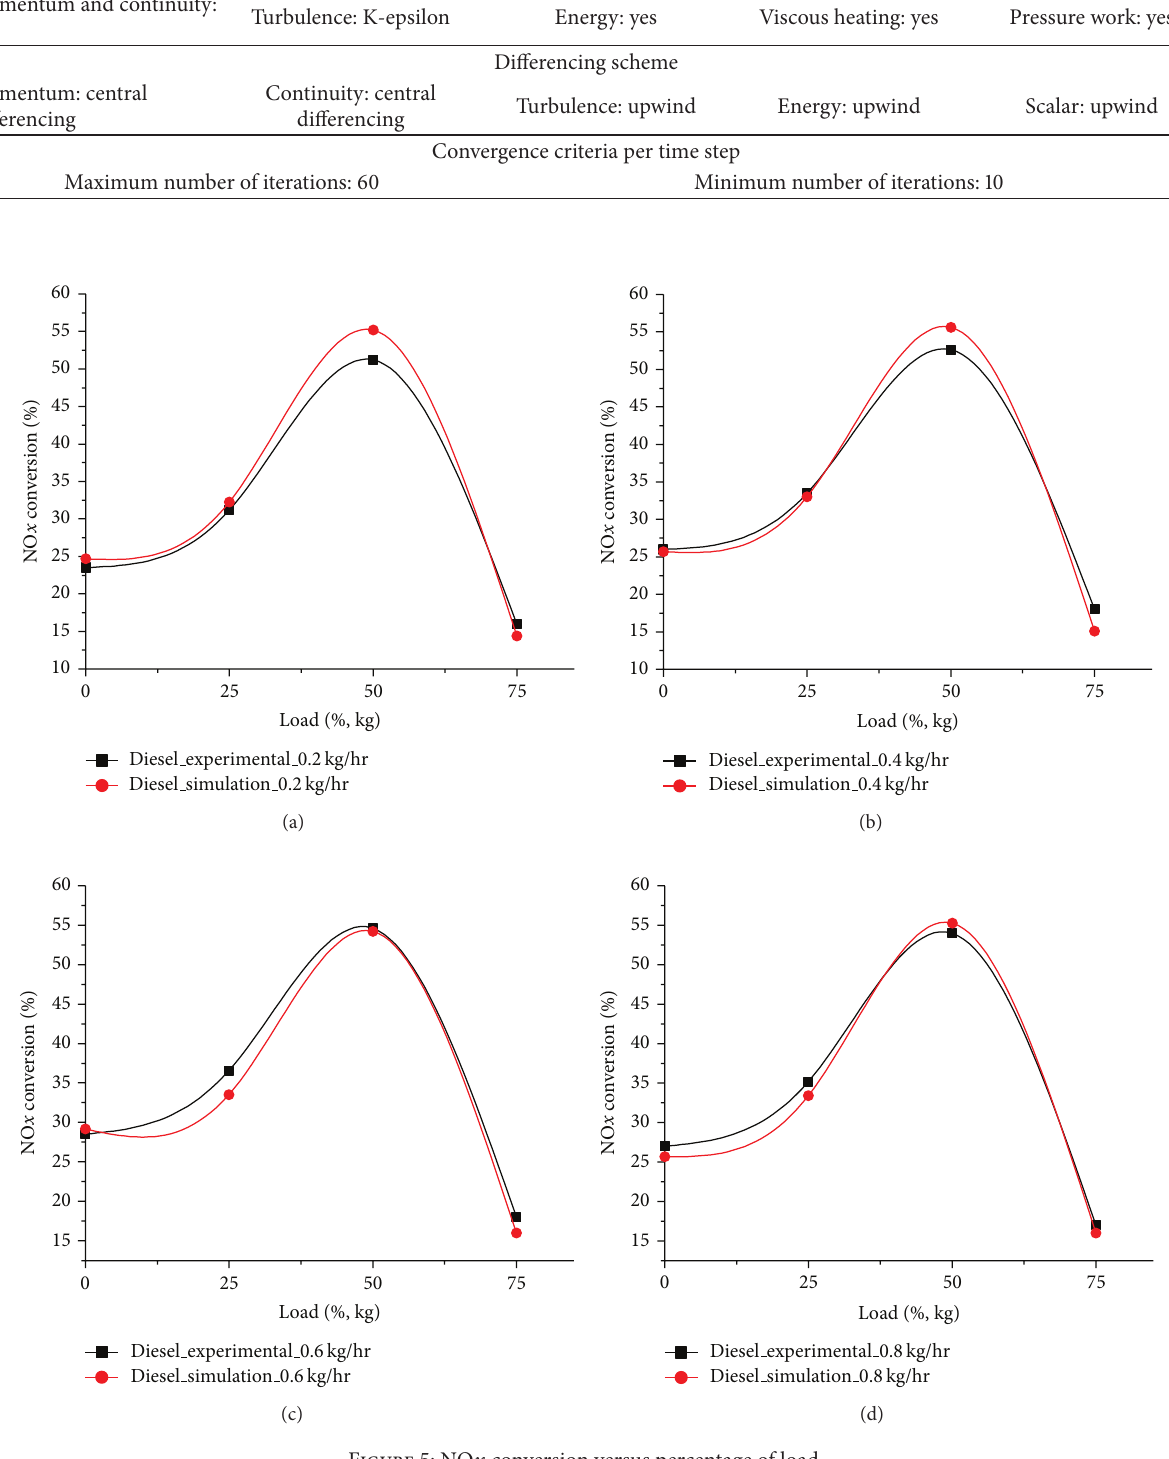
Figure 5: NO 𝑥 conversion versus percentage of